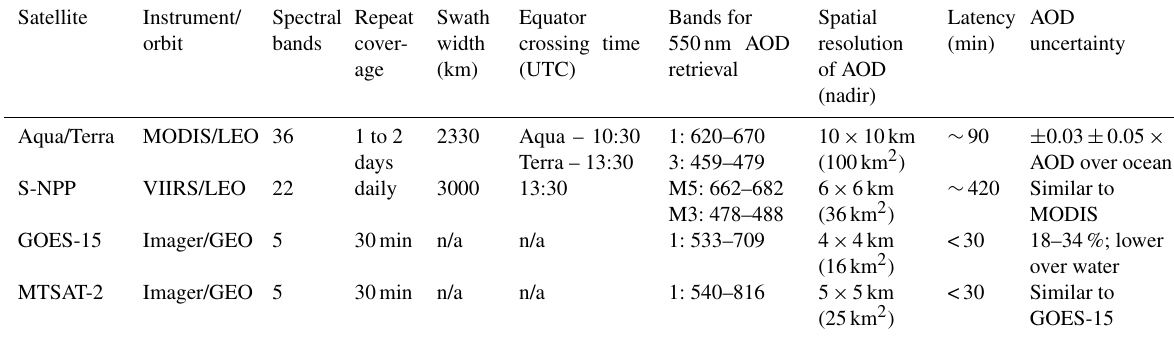
Table 1. Summary of satellites instruments used in producing the NRT AOD product Satellite Instrument/ orbit